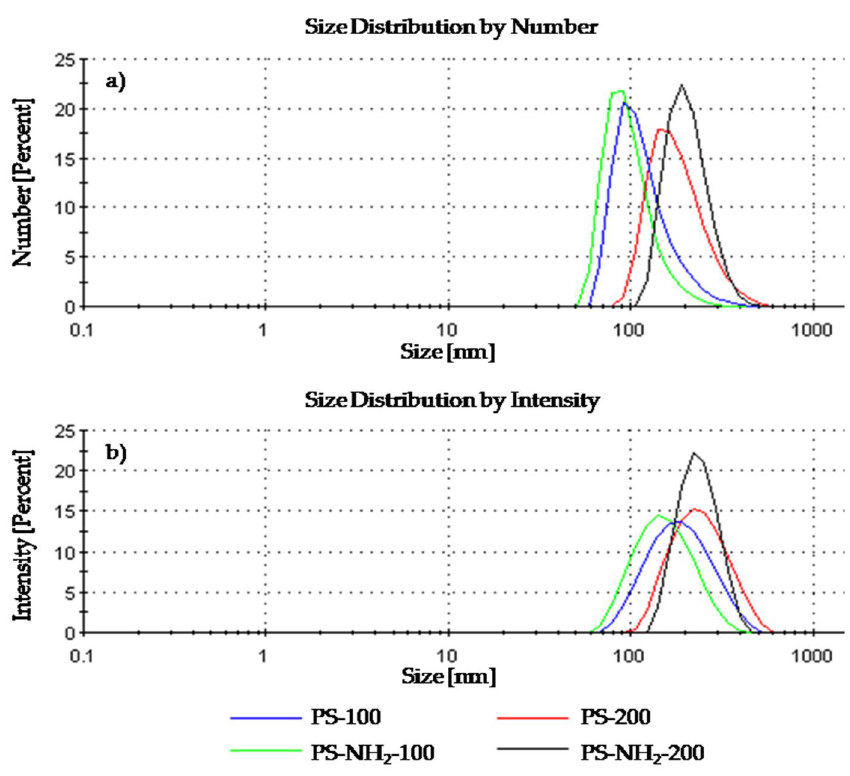
Figure 2. Polystyrene size distribution by ( a ) number, ( b ) intensity.